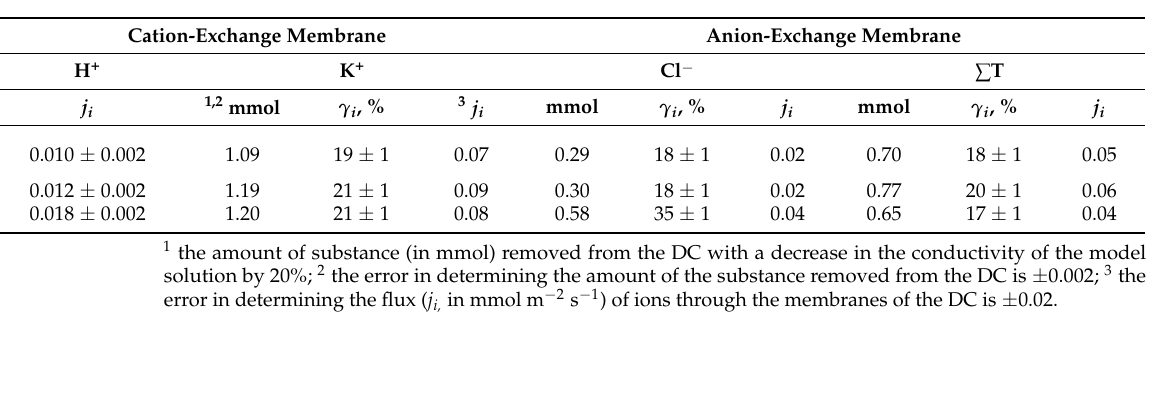
Table 3. Some parameters of electrodialysis processing of model solution at a degree of demineraliza- tion equal to